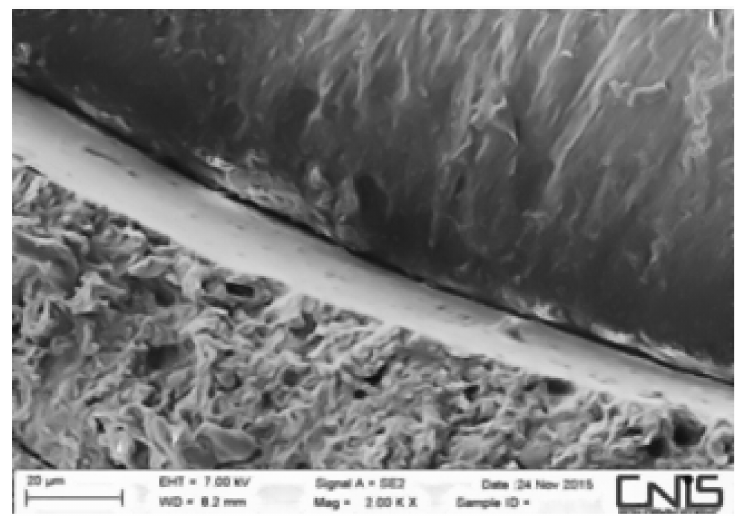
Figure 8. Interface between dentin and sealant. Section of medium third G system.